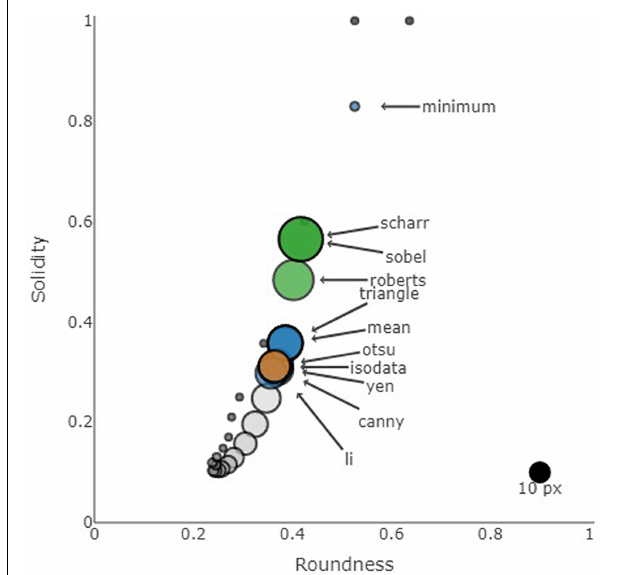
FIGURE 8 | Median roundness and solidity for all threshold algorithms. The symbol size shows the median particle size for each algorithm (reference point of 10 px in diameter shown in black in bottom right corner). Blue symbols: binary algorithms, orange symbol: Otsu, green symbols: edge detection algorithms, gray symbols: static threshold with symbol color representing the threshold. Based on all imaged particles ( n =